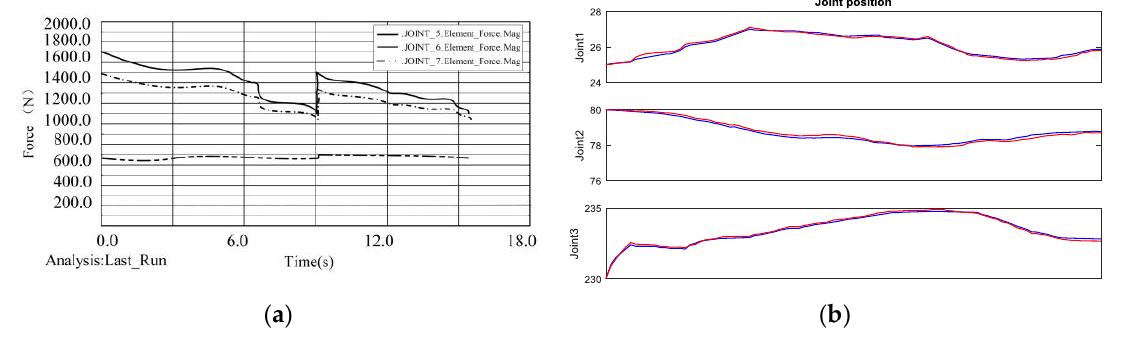
Figure 6. ( a ) The forces of three joints in Adams; ( b ) Trajectory following.